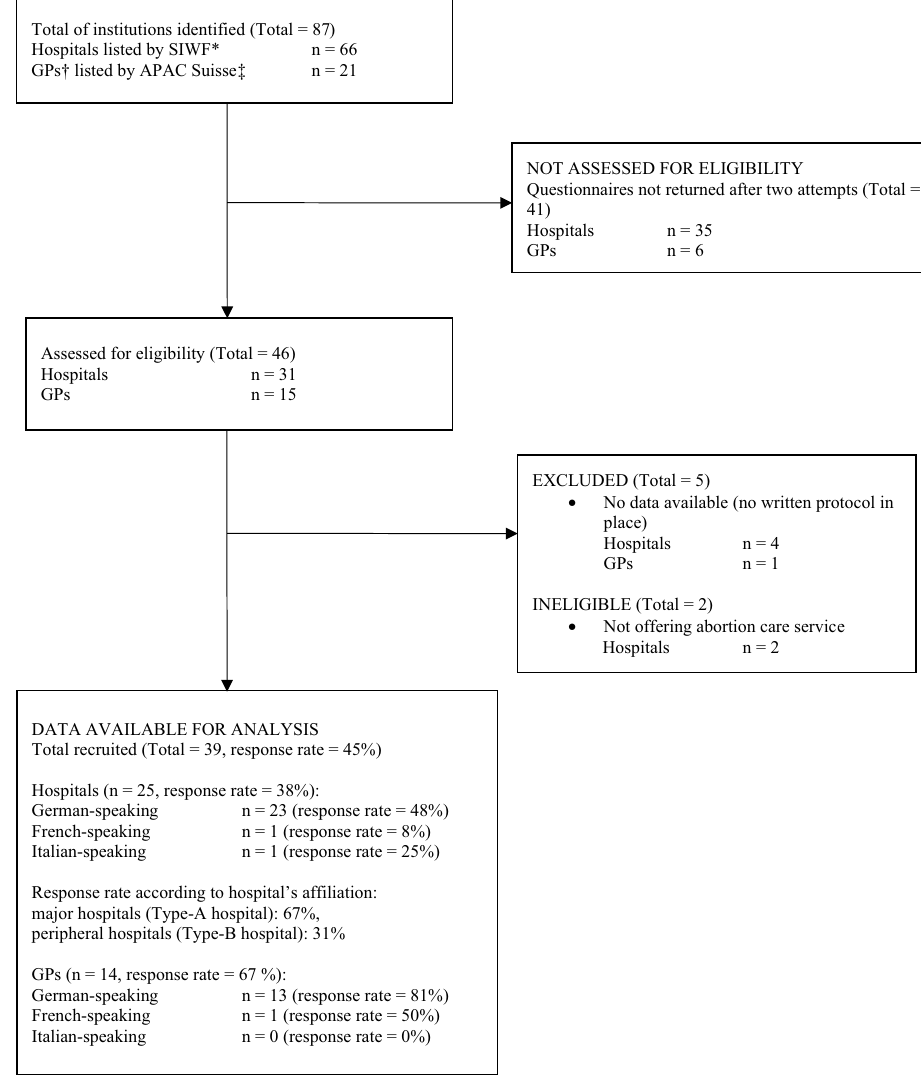
Figure 1 Methodical selection process of appropriate institutions